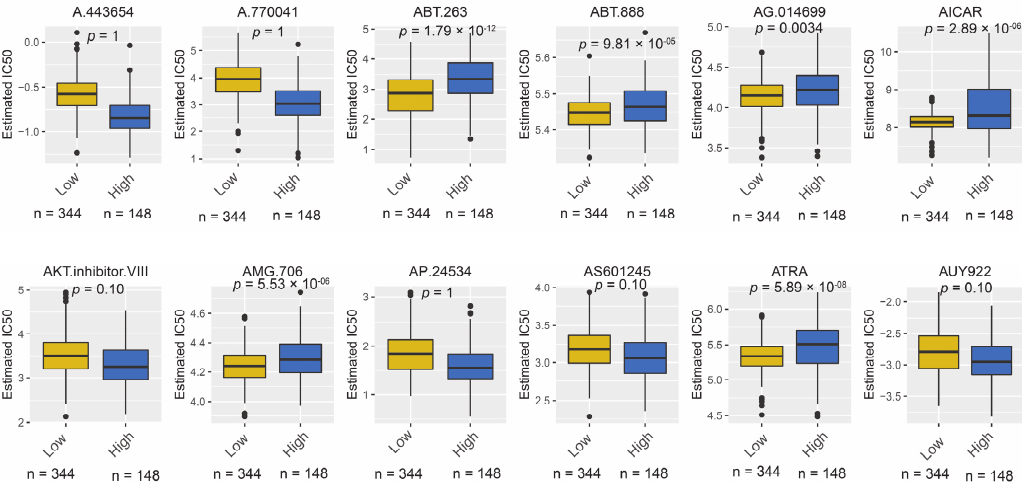
Figure 12. Estimated drug sensitivity in patients with high- and low-PyroScore